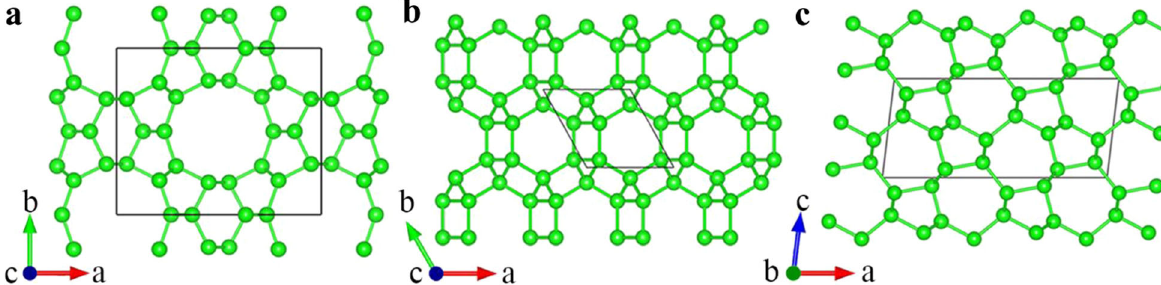
Fig. 4 Structural con fi gurations of the Si allotropes. Crystal structures of a oC24-Si, b tP6-Si, and c mC8-Si at 0 GPa.